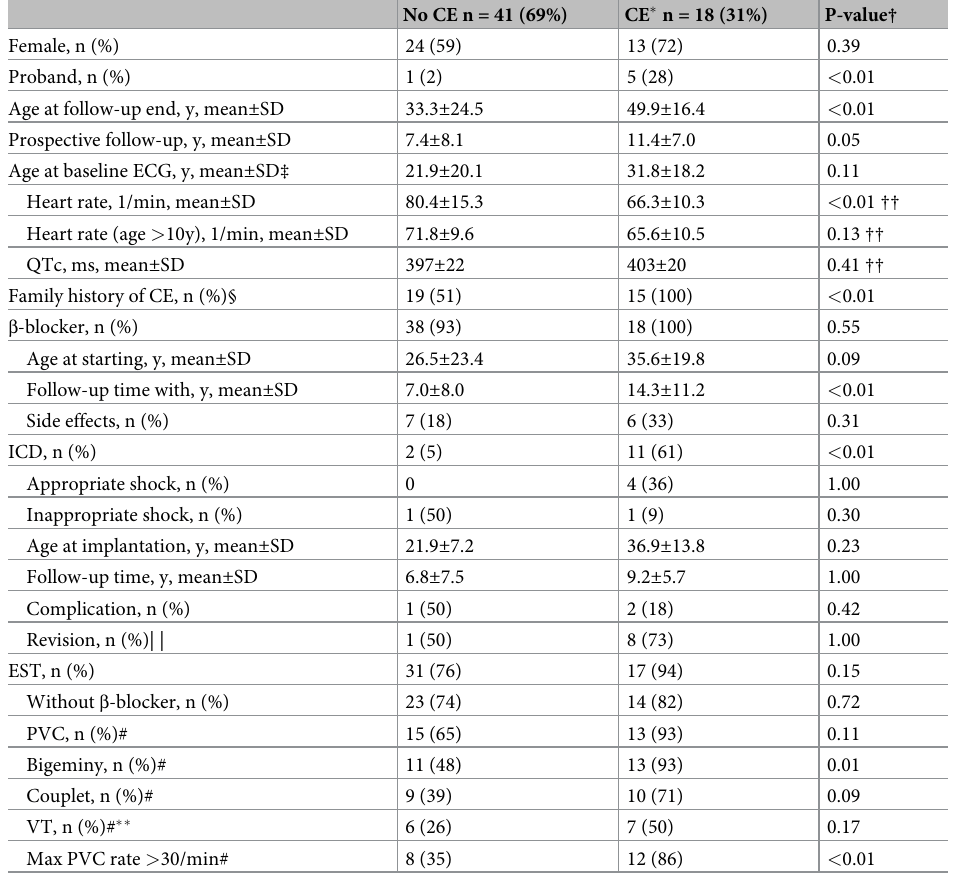
Table 1. Characteristics of RYR2 P2328S mutation carriers by symptom